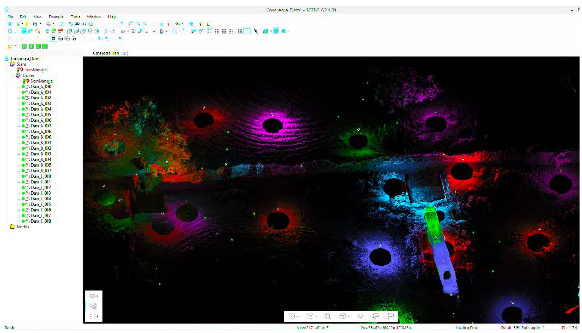
Figure 4. Screen capture showing registered TLS point cloud of Roman Dam in SCENE 5.5.3